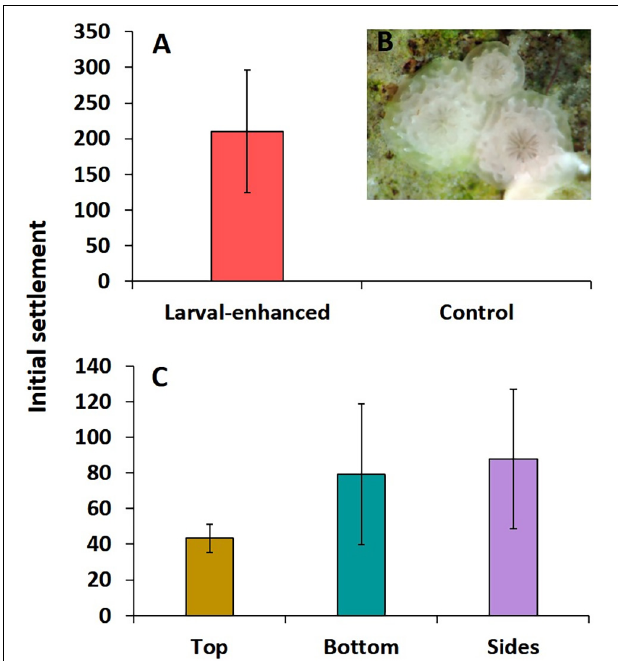
FIGURE 4 | Initial mean A. tenuis larval settlement on tiles in larval enhanced ( N = 3) and control ( N = 3) plots after 5 days larval settlement (A) , three newly settled spat with well developed primordial skeletons (B) , and mean settlement on different tile surfaces in the larval enhanced plots (C) . Error bars are ± SE.